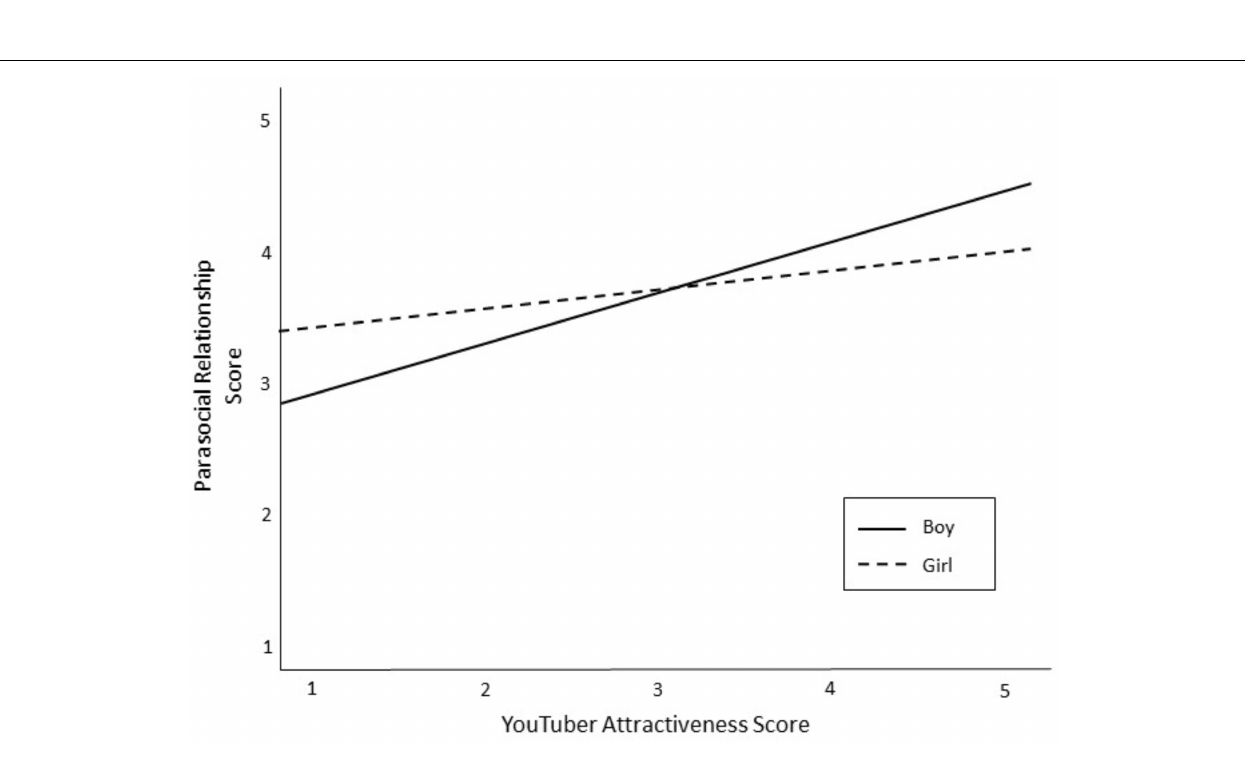
FIGURE 3 | The relationship between YouTuber attractiveness and PSR as moderated by gender of